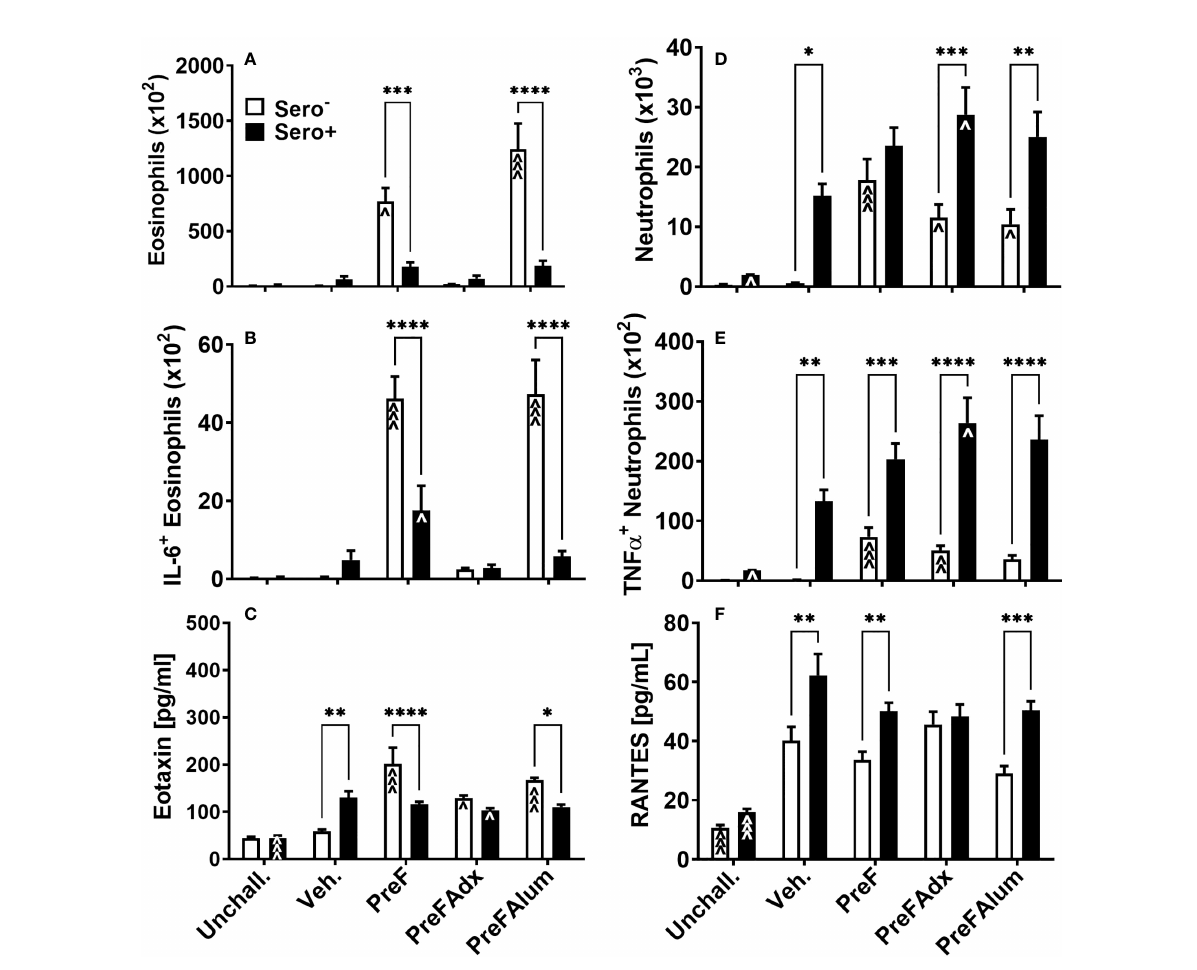
FIGURE 5 Eosinophils and neutrophils are differentially increased in immunized sero- and sero+ mice. Sero- and sero+ mice were immunized and challenged with virus as described in Figure 1. At 4dpi, BAL was harvested for quanti fi cation of eosinophils (A) , IL-6+ eosinophils (B) , neutrophils (D) , and TNF a + neutrophils (E) . Soluble eotaxin (C) and RANTES (F) were determined in the BAL by Luminex. Data are represented as mean ± SEM of two independent experiments ( n = 8 mice). Statistical signi fi cance was determined between sero- and sero+ groups within each immunization cohort using 2-way ANOVA with a Bonferroni post-test; *p<0.05, **p<0.01, ***p<0.001, and ****p<0.0001. Comparisons to Veh. controls within the respective sero- and sero+ groups were made using an ANOVA with a Dunnett ’ s multiple comparison test; ^p<0.05, ^^p<0.01, and